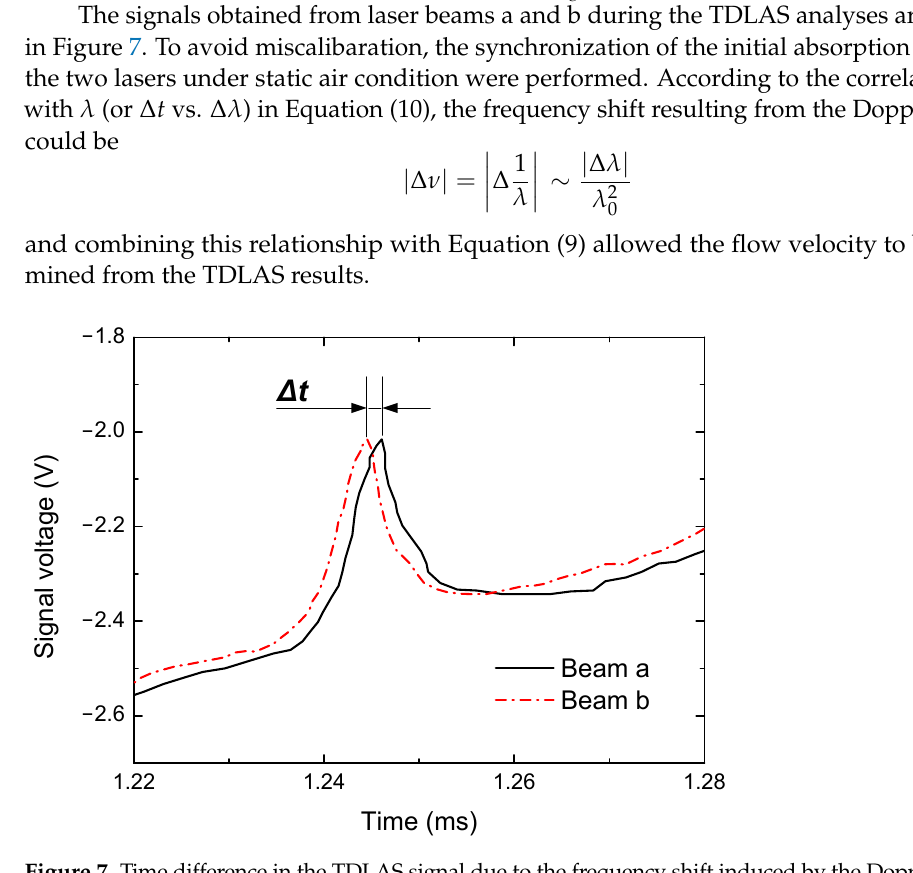
Figure 7. Time difference in the TDLAS signal due to the frequency shift induced by the Doppler effect.